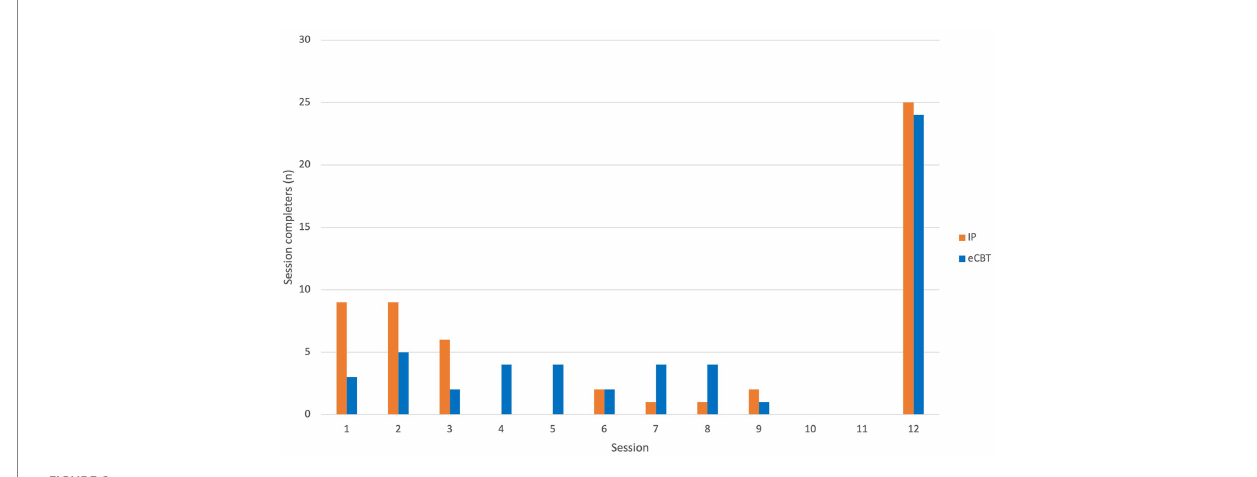
FIGURE 6 Frequency of participants’ last completed sessions organized by CBT delivery